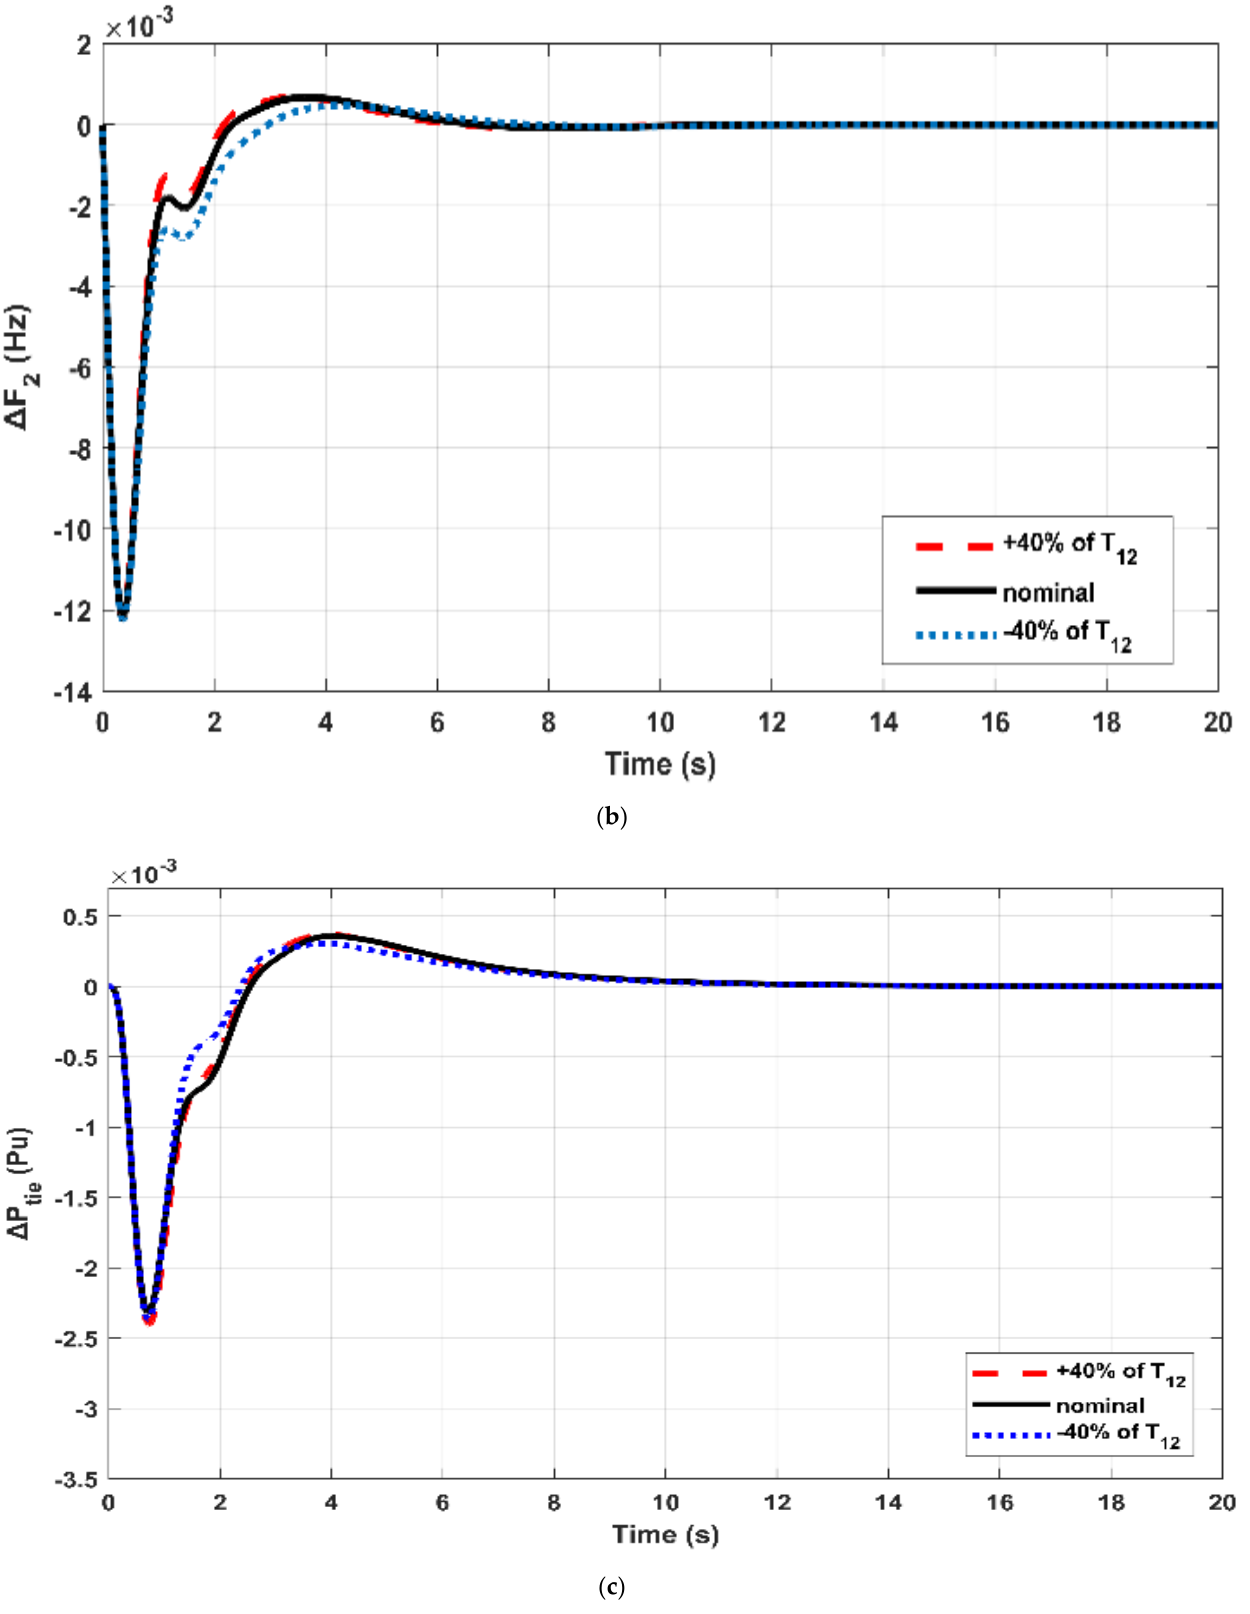
Figure 12. Robustness performance of proposed MFOPID controller for: ( a ) ∆ F 1 ; ( b ) ∆ F 2 ; ( c ) ∆ P ite . Table 4. Sensitivity analysis of the proposed controller for hybrid PS.